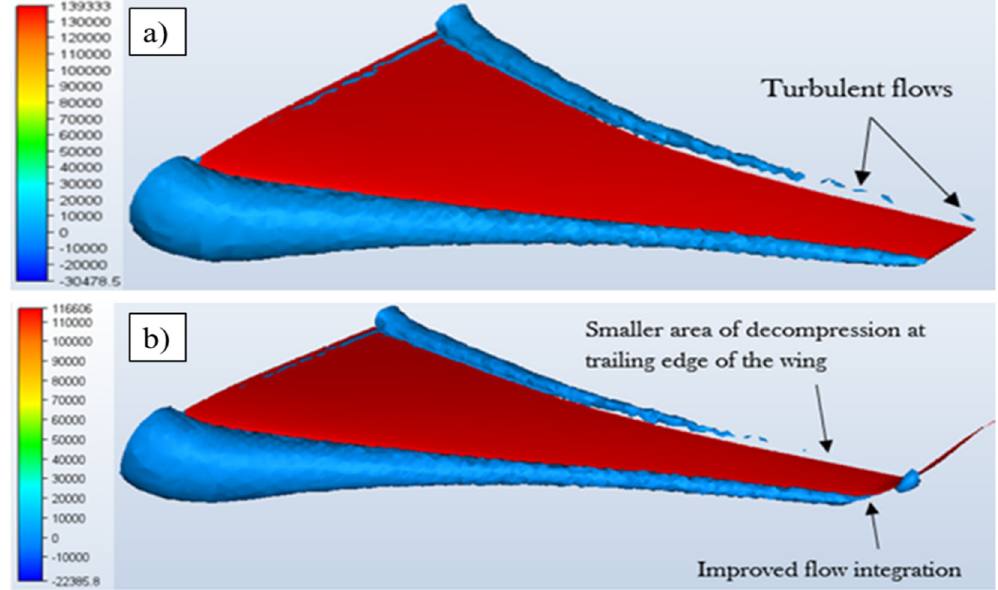
Figure 10. Pressure plot on ( a ) unmodified wing and ( b ) modified wing.